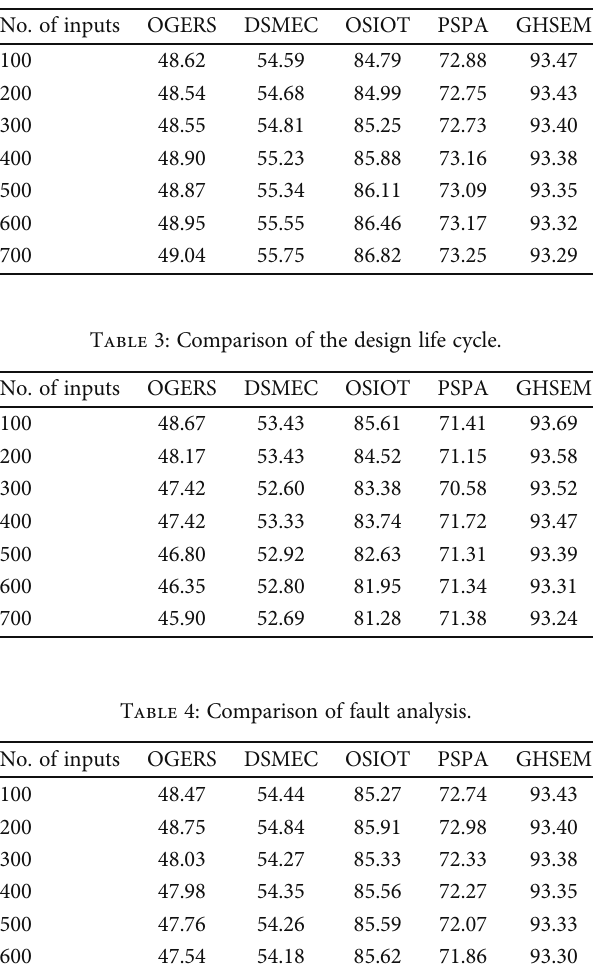
Table 2: Comparison of design review and inspection.